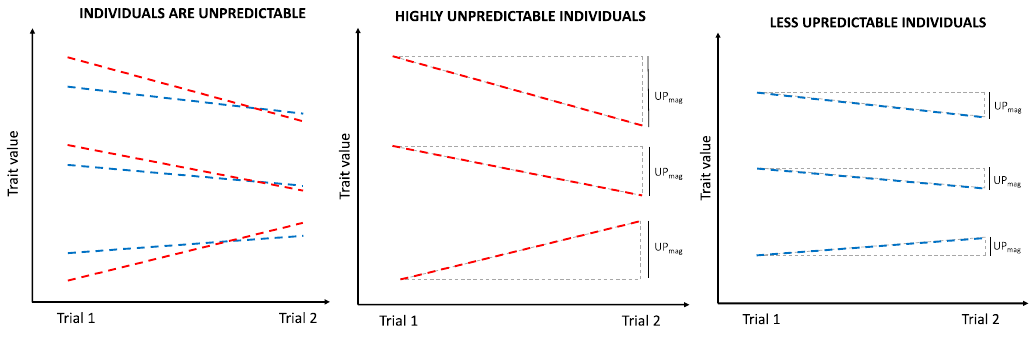
Figure 1. Illustration of intra-individual variation. The magnitude of intra-individual variation was calculated as the absolute difference between the behavioural trait value obtained during the first trial and second trial.